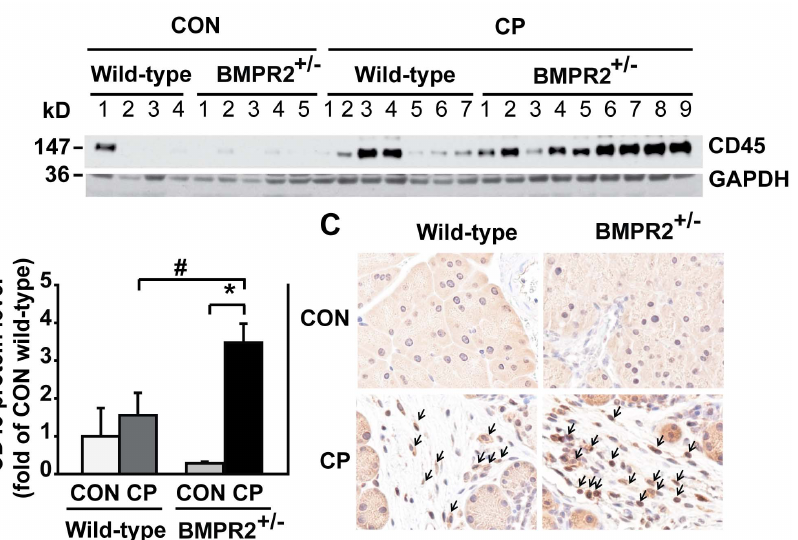
Figure 3. BMPR2 deficiency increased leukocyte infiltration in the pancreas after CP induction. (A) Western blotting of pancreatic tissue lysates with anti-CD45 antibody. (B) Quantification of CD45 Western blots. The protein levels were normalized against GAPDH and quantified as fold of CON wild-type. CON wild-type: n=4, CON BMPR2 + / 2 : n=5, CP wild-type: n=7, CP BMPR2 + / 2 : n=9. * P , 0.05 compared with CON, # P , 0.05 compared with CP wild-type. (C) Representative images of immunohistochemistry on paraffin-embedded pancreatic sections against CD45. Arrows point to CD45 positive cells. Original magnification 6 400.